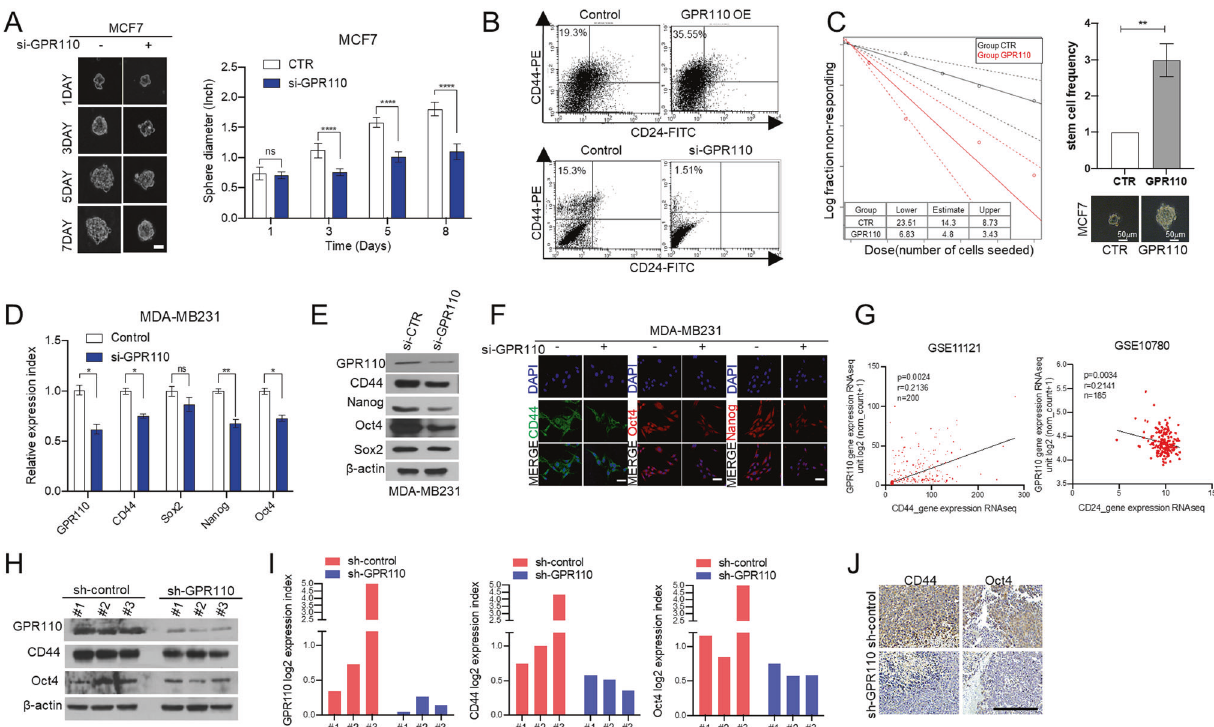
Fig. 3 GPR110 promotes breast cancer stem-like cells. A Sphere formation assay was performed using GPR110-overexpressing MCF7 and the colony size was measured and shown in a graph. Representative images of forming cells showing the growth of the sphere (left). Scale bar: 20 μ m. The graph showed the size of spheres formed (right). B Flow cytometric analysis of the percentage of CD44 + /CD24 − cells in the GPR110-overexpressing MCF7 and GPR110-silenced MDA-MB231 cells. C in vitro Limiting dilution assay was performed using GPR110- overexpressing MCF7 cells. D , E qRT-PCR and Western blotting analysis were performed to check the CSC regulators after silencing GPR110 in MDA-MB231. F Representative ICC Image of CD44, OCT4 and NANOG in GPR110-silenced MDA-MB231 cells. G A positive correlation between CD44 and GPR110 was observed using the public GSE database (GSE11121) and a negative correlation between CD24 and GPR110 was observed using the public GSE database (GSE10780). H – J Western blotting, qRT-PCR analysis, and IHC staining of CSC regulators using mouse tissues. Scale bar = 100 μ m. * p < 0.05, ** p < 0.001 and **** p < 0.0001; ns not signi fi cant; determined by two-tailed Student ’ s t test (95% con fi dence